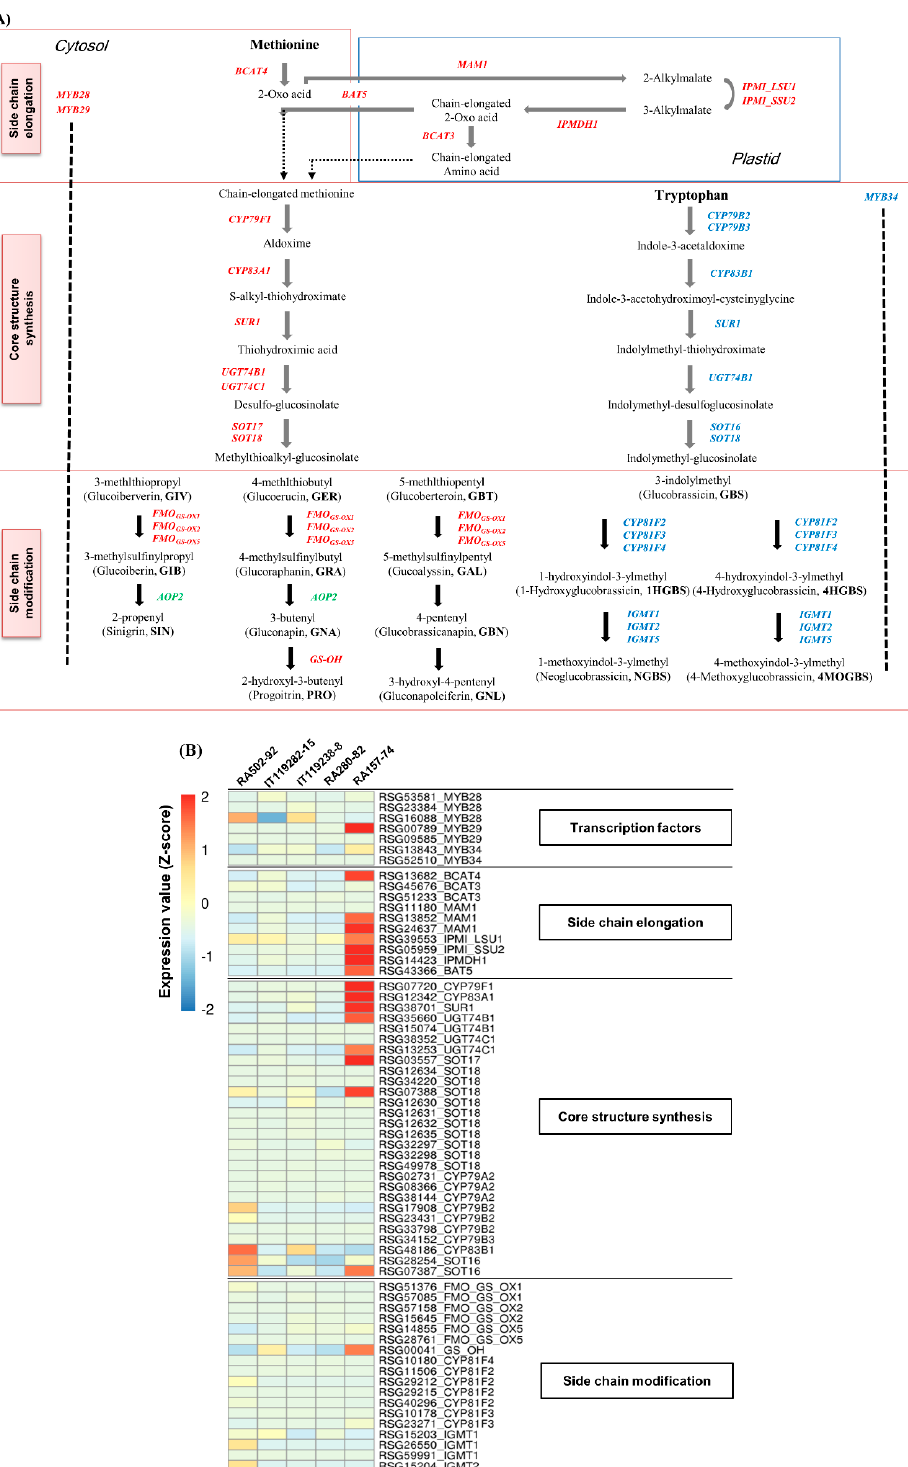
Figure 4. GSL biosynthesis in the Brassicaceae family. ( A ) Genes involved in aliphatic and indolic GSL biosynthesis are marked in red and blue, respectively. Undetected genes in the transcriptome of radish roots are noted in green. Dotted arrows in the side chain elongation step indicate the putative function of unknown enzymes. ( B ) Heat map analysis of genes involved in GSL biosynthesis in radish roots. Expression values (FPKM) of individual genes were normalized by Z-score and scaled per row (i.e., per gene) for the visualization of the expression peaks of genes among the